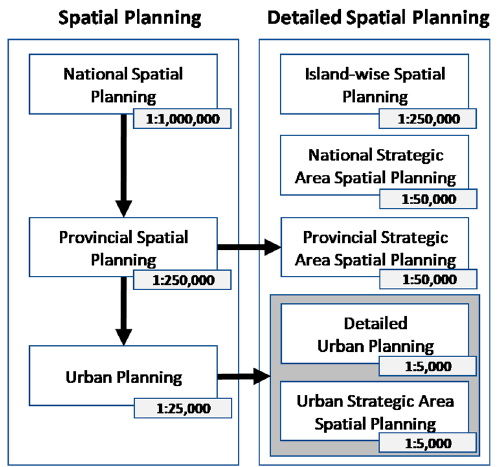
Figure 3. Detailed Urban Planning in Indonesian Spatial Planning System according to the Minister of Public Work Decree 20 Year 2011 [67].